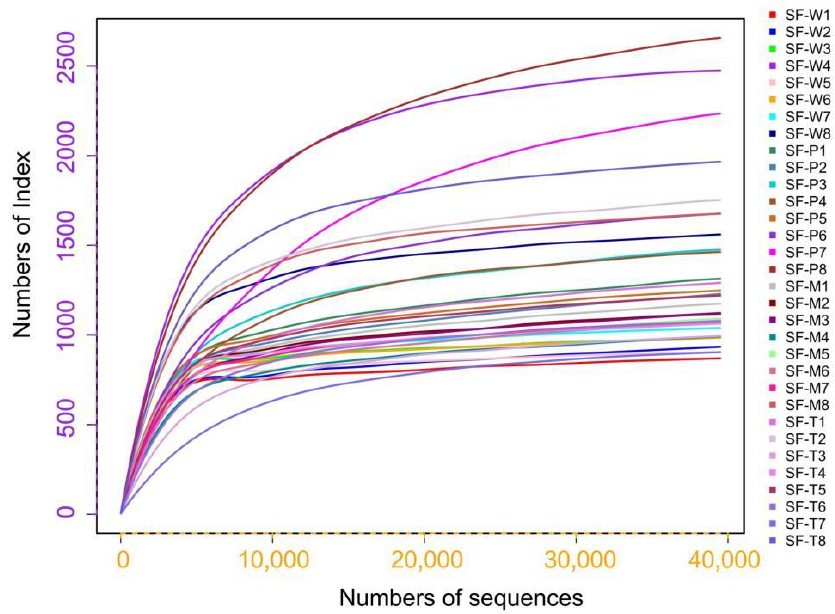
Figure 1. Rarefaction curve of intestinal bacterial species in the 5th instar larvae of S. frugiperda. Eight replicates were set up for each group, with the numerals 1–8 after the sample name representing different replicates.